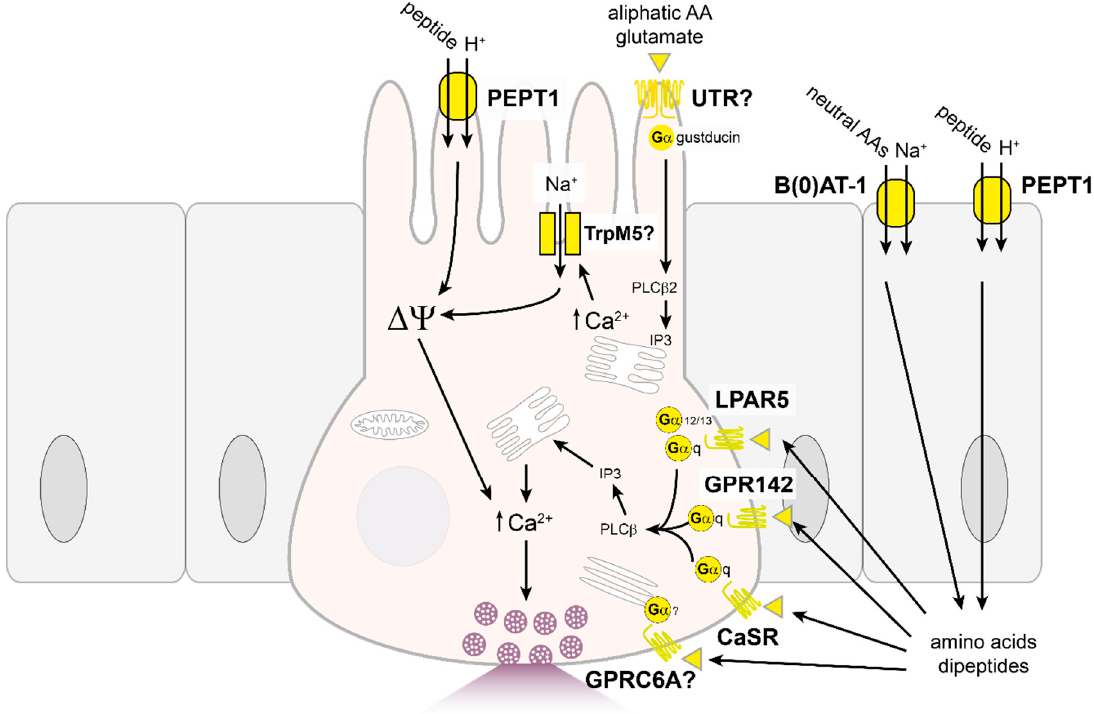
Figure 3. Protein-sensing mechanisms in incretin hormone secreting EECs. Schematic as in Fig2. Good evidence exists for a role of PEPT1, CaSR and GPR142 in incretin secretion, however, the exact locations of receptors and transporters are incompletely defined. Controversial contributors are marked with a question mark (see text for details). Abbreviations: AA, amino acid; B(0)AT-1, sodium-dependent neutral amino acid transporter; CaSR, calcium-sensing receptor; GPR142, G- protein coupled-receptor 142; GPRC6A, G protein-coupled receptor family C group 6 member A; IP3, inositol triphosphate; LPAR5, lysophosphatidic acid receptor 5; PEPT1, H + /peptide co-transporter; PLC β , phospholipase C beta; TrpM5, transient receptor potential cation channel subfamily M member 5; UTR, umami taste receptor; ∆Ψ , membrane